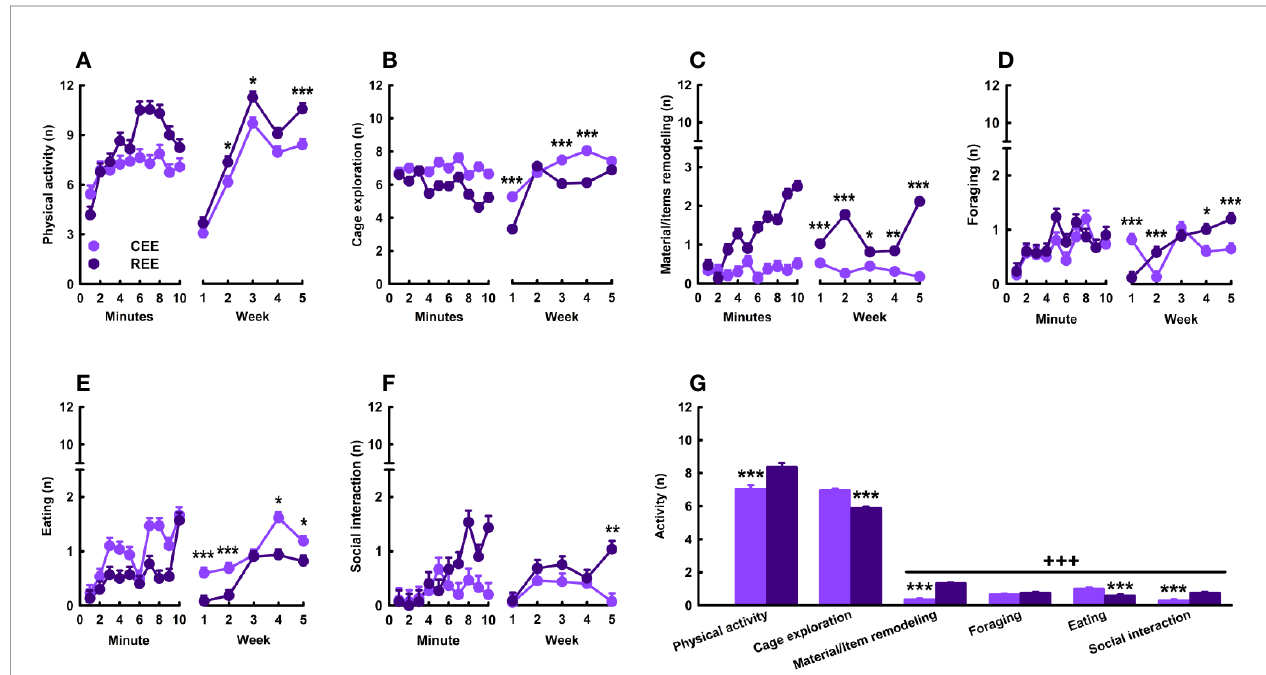
FIGURE 3 | Behavioral kinetics in the environmental enrichment cage. Physical activity (A) , cage exploration (B) , material/items remodeling (C) , foraging (D) , eating (E) , and social interaction (F) displayed over minutes (left panels) and weeks (right panels). Cumulative average activity (G) . Data correspond to frequencies expressed as mean ± SEM. CEE, continuous environmental enrichment; REE,restricted and unpredictable environmental enrichment. Single, pairwise-comparisons between groups: * p < .05; ** p < .01; *** p < .001. Comparison between behaviors: +++ p <